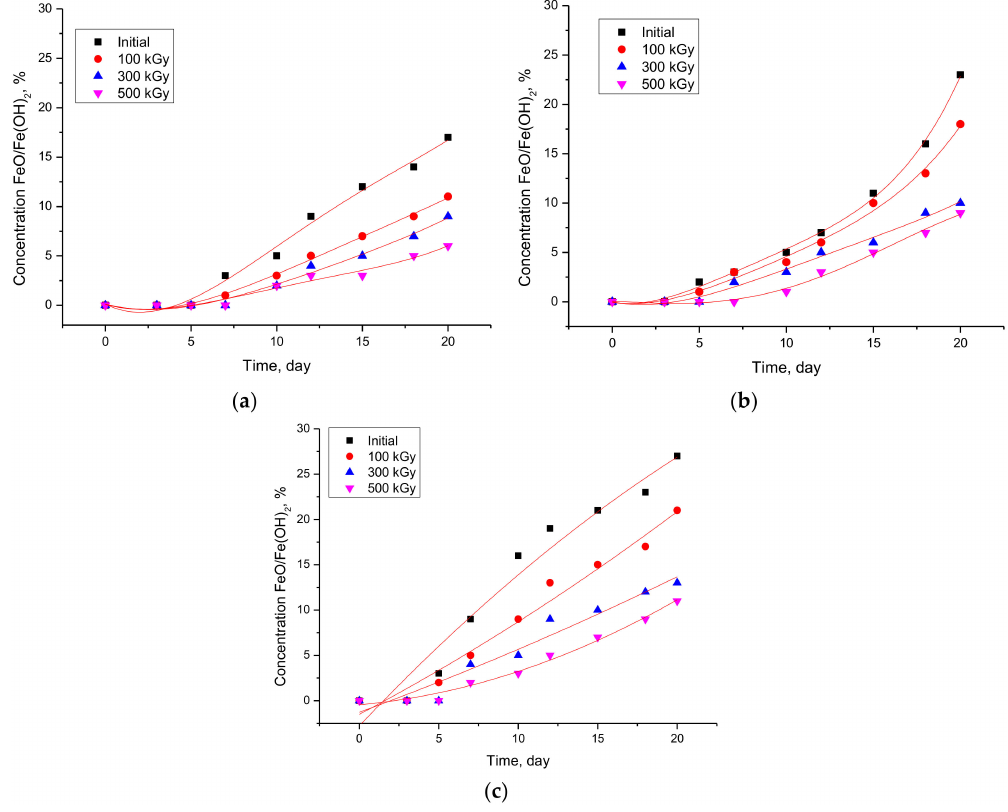
Figure 8. Graph of the change in the concentration of oxide phases in the structure of nanotubes: ( a ) at a test temperature of 25 ◦ C; ( b ) at a test temperature of 36 ◦ C; ( c ) at a test temperature of 40 ◦